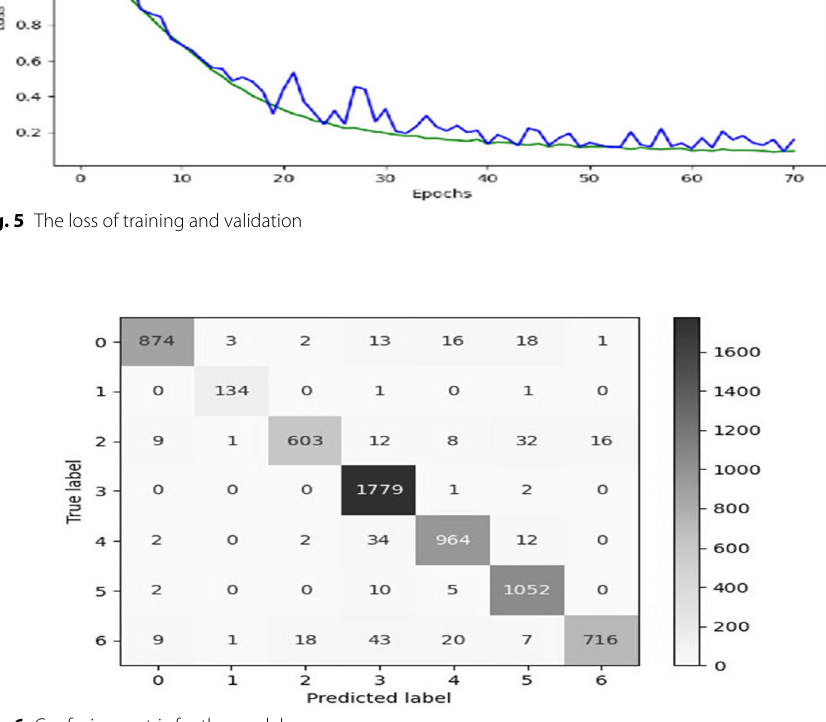
Fig. 6 Confusion matrix for the